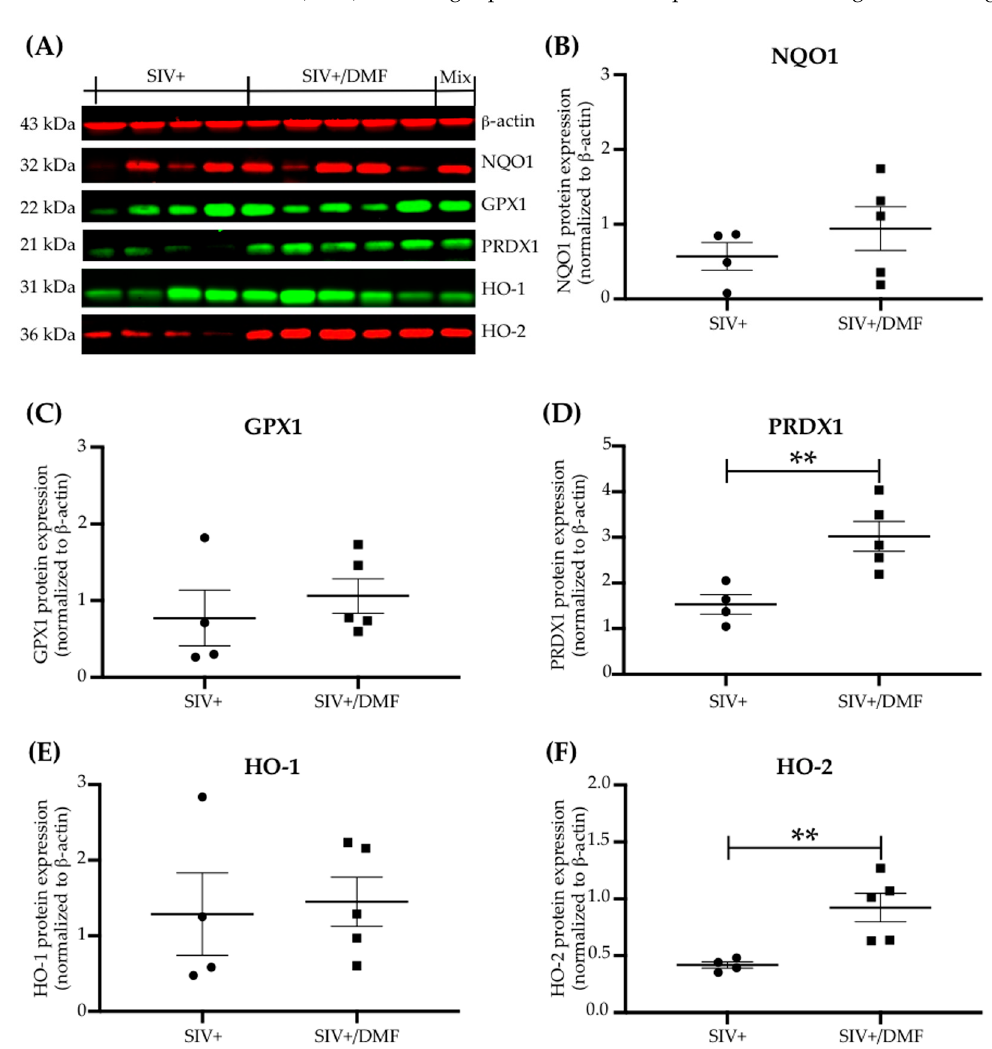
Figure 5 . DMF treatment was associated with higher antioxidant enzyme expression in the spleens of SIV-infected macaques. ( A ) Representative immunoblot for the antioxidant enzymes assessed. β -Actin was used as a loading control. ( B , C ) No significant differences in the expression of NQO1